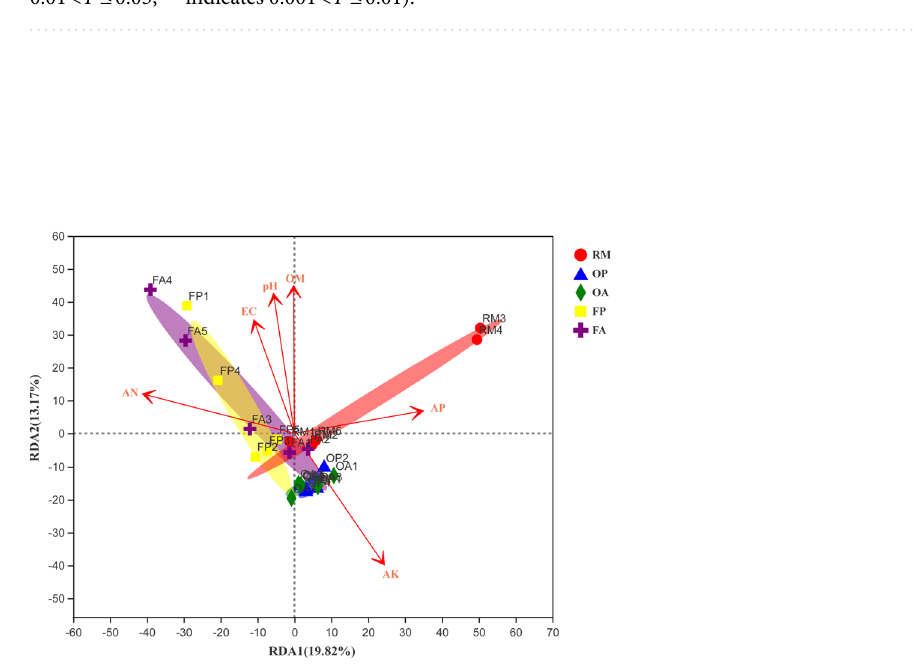
Figure 6. The differences with significance of the top 30 genera in different rice systems and areas (* indicates 0.01 < P ≤ 0.05, ** indicates 0.001 < P ≤ 0.01).